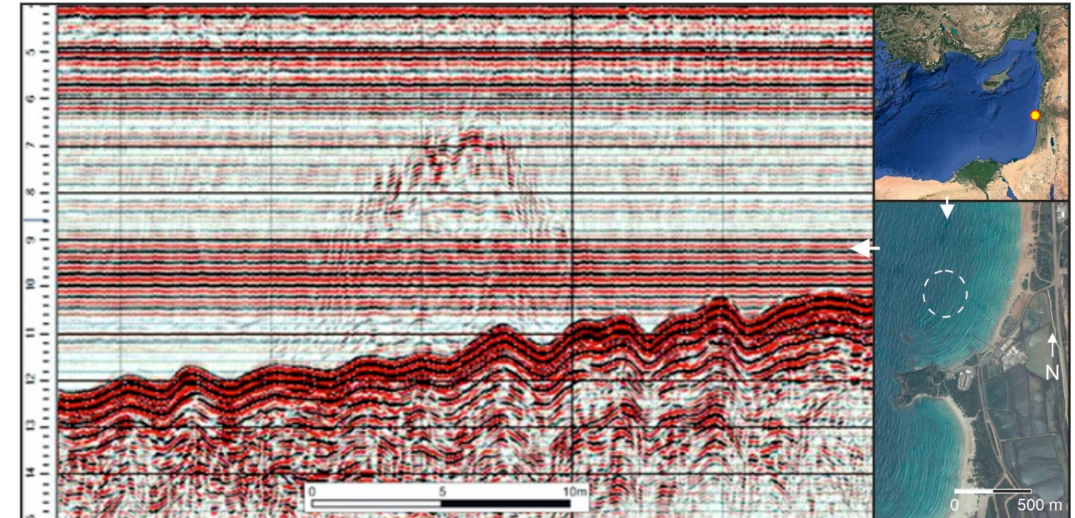
Figure 8. Left: A characteristic example of a haystack feature recorded at Atlit Yam. The seafloor is evident as a dark ‘wavy’ line below the haystack and the cultural layer as a dark horizon approximately 2 m below the seafloor. The depth is shown in metres to the left. Horizontal noise bands can be seen in the water phase. Right: location of Atlit Yam in the Mediterranean Sea ( top ) and off the Carmel Coast ( bottom ) Graphic: Grøn.